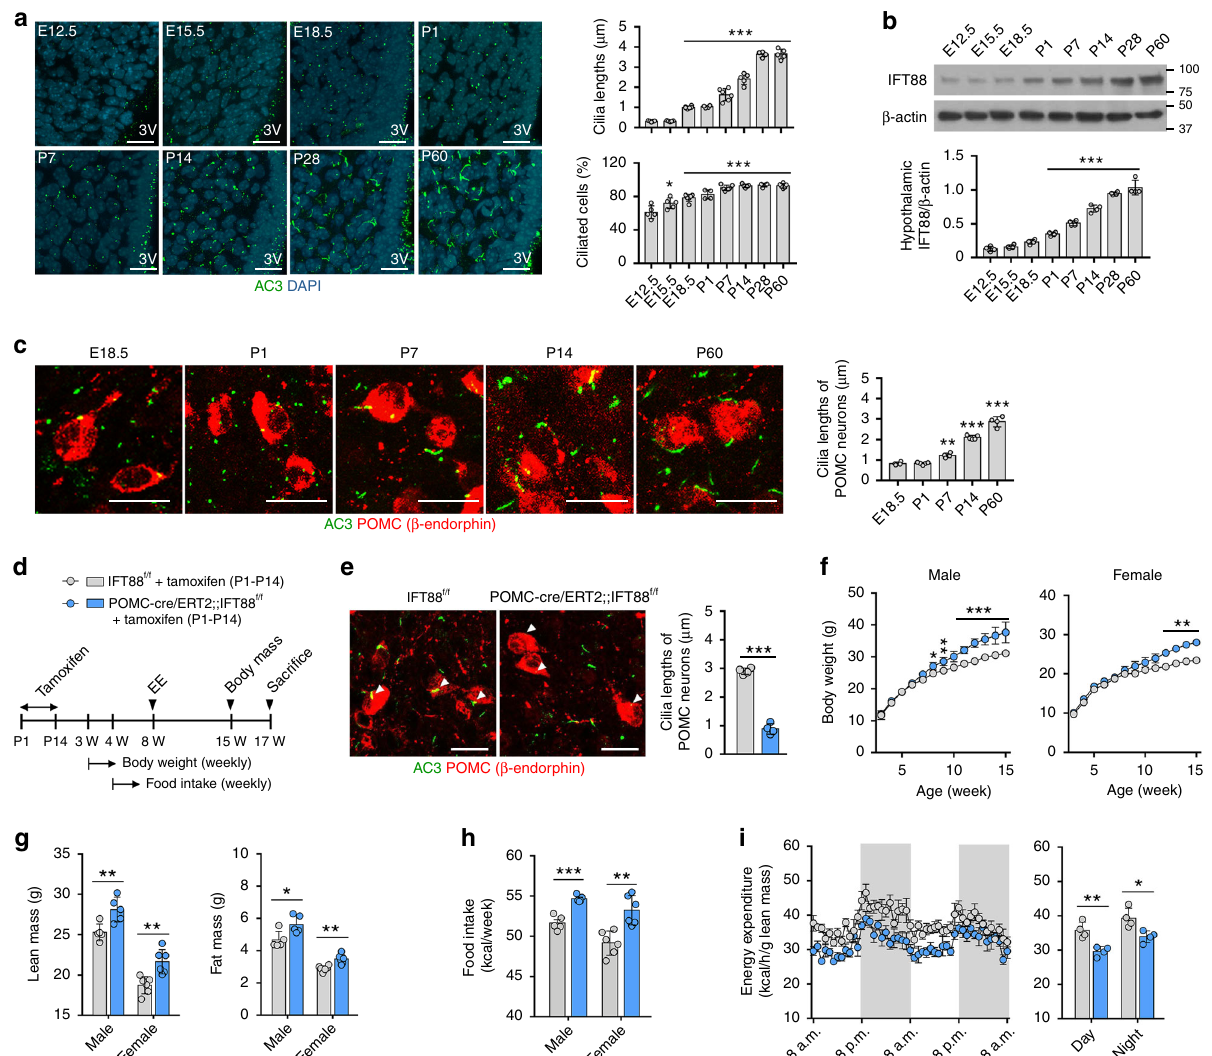
Fig. 3 Ciliogenesis in POMC neurons during the early postnatal period is critical for adulthood energy balance. a Cilia (AC3) staining in the developing hypothalamus of C57 mice ( n = 4 for P0 and P28, n = 5 for E12.5, E15.5, P14, and P60, n = 6 for E18.5 and P7). The graphs depict the average length of about 100 ARH cilia and the ciliated cell percentage (the cilia numbers divided by the DAPI numbers) in each mouse. Scale bars: 20 μ m. 3V third cerebroventricle. b IFT88 immunoblotting in the developing hypothalamus of C57 mice ( n = 4). c AC3 and β -endorphin double staining in the ARH of C57 mice showing POMC neuron ciliogenesis during development ( n = 4 for E18.5, P7, and P60, n = 5 for P1 and P14). Scale bars: 20 μ m. d Experimental scheme in mice with POMC-speci fi c IFT88 depletion that was induced by tamoxifen injections during the postnatal period (P1 – P14). e Representative cilia images showing ciliary dysgenesis in POMC neurons ( n = 4). Arrowheads indicate cilia of POMC neurons. Scale bars: 20 μ m. f Body weights in mice with postnatal ciliary dysgenesis in POMC neurons and their IFT88 f/f litters on a chow diet ( n = 5 for males, n = 6 for females). g Lean mass and fat mass measured at 15 weeks ( n = 5 for males, n = 6 for females). h Average values of weekly food intake during 10 – 15 weeks ( n = 5 for males, n = 6 for females). i Energy expenditure measured at 12 weeks ( n = 4). Data are presented as the mean ± SEM values. Statistics were performed using one-sided one-way ANOVA ( a – c ), one-sided two-way ANOVA ( f ) followed by post hoc LSD test and two-sided Student ’ s t test ( e , g – i ). * p < 0.05, ** p < 0.01, *** p < 0.001 vs. IFT88 f/f controls or between the indicated